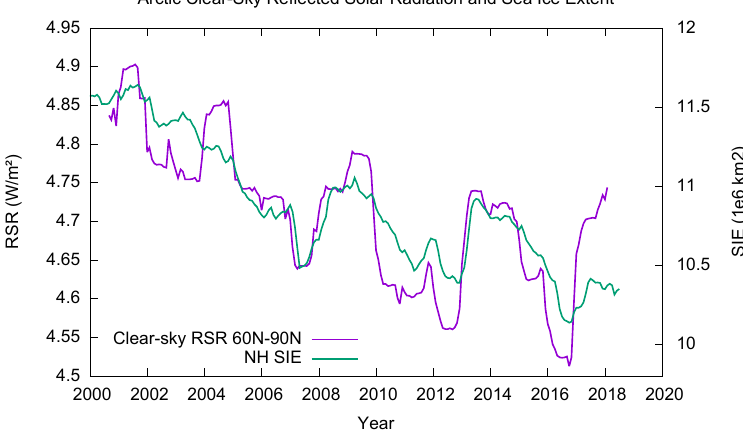
Figure 8. Arctic clear-sky RSR compared to Arctic SIE. Purple curve, left scale: Clear-sky RSR contribution of zone from 60 ◦ N to 90 ◦ N. Green curve, right scale: Arctic SIE. The correlation between the Arctic clear-sky RSR and the Arctic SIE is 85%. The ratio between the variations of the two quantities is 0.199 ± 0.009 (1 σ ) W/m 2 / M km 2 . Over the 2000–2018 period the Arctic clear-sky RSR shows a decreasing trend of − 0.13 W/m 2 dec. Figure 9 shows the RSR contribution for the Antarctic zone defined as 90 ◦ S to 60 ◦ S (purple curve, left scale) compared to the Antarctic SIE (green curve, right scale). We use the yearly running mean of the NSIDC SIE.